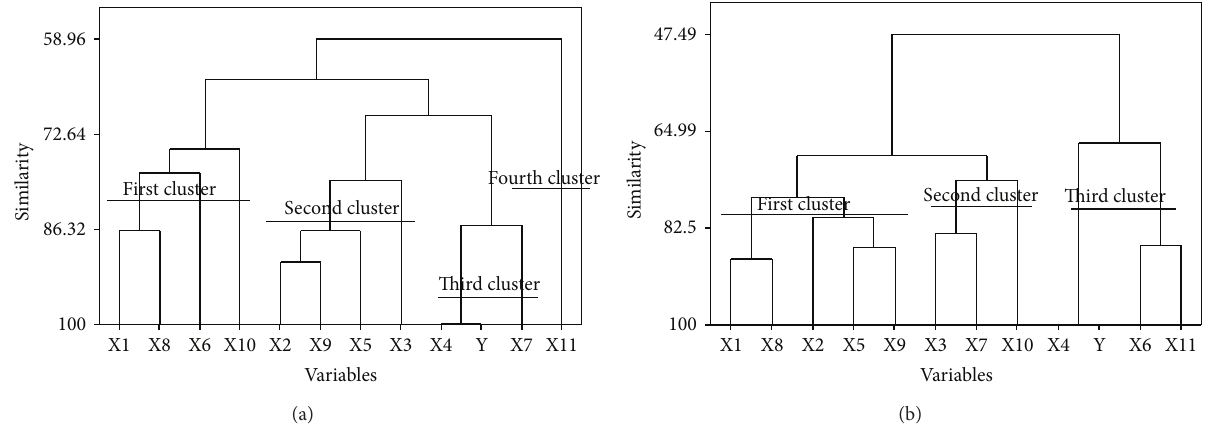
different water levels. X1: tiller numbers/plant, X2: spike length, X3: spikelets/spike, X4: spike weight/plant, X5: grain number/spike, X6: grain weight/spike, X7: 100-grain weight, X8: total chlorophyll content of flag leaf, X9: biological yield/plant, X10: root weight, X11: leaves area and Y: grain yield. (b) Similarity levels of the estimated twelve wheat variables using the hierarchical cluster analysis under noninoculation condition and different water levels. X1: tiller numbers/plant, X2: spike length, X3: spikelets/spike, X4: spike weight/plant, X5: grain number/spike, X6: grain weight/spike, X7: 100-grain weight, X8: total chlorophyll content of flag leaf, X9: biological yield/plant, X10: root weight, X11: leaves area and Y: grain